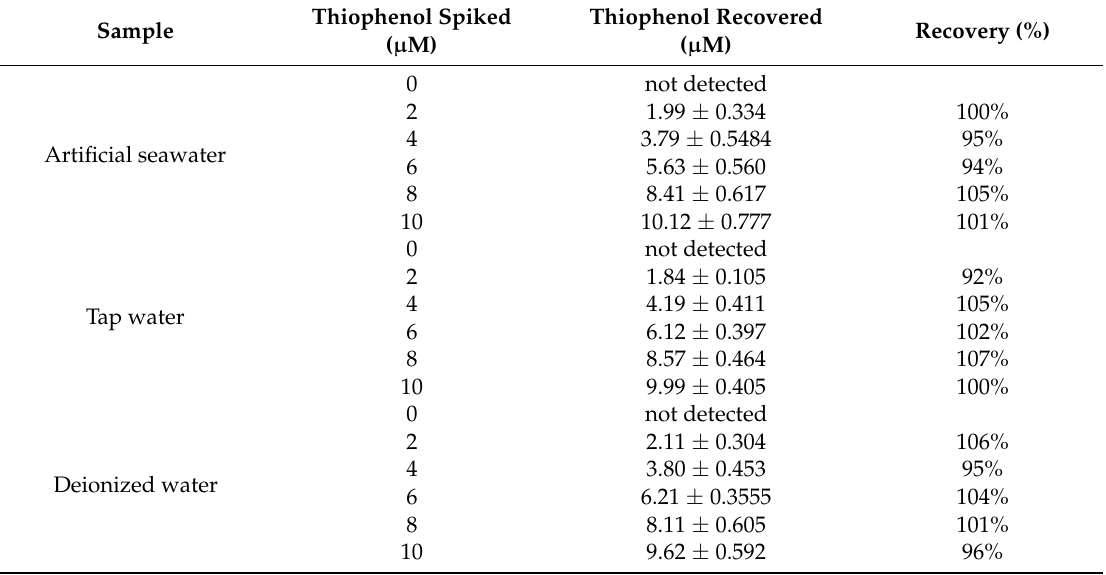
Table 1. Determination of thiophenol concentrations in water